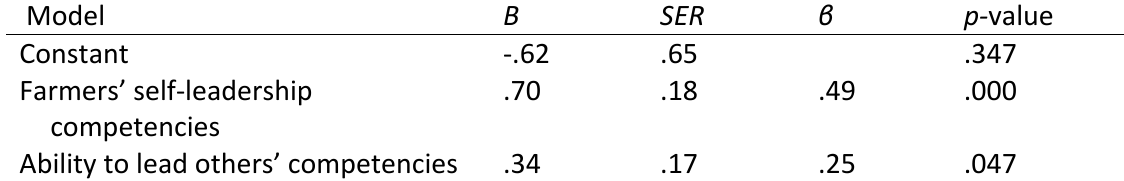
Multiple Relations